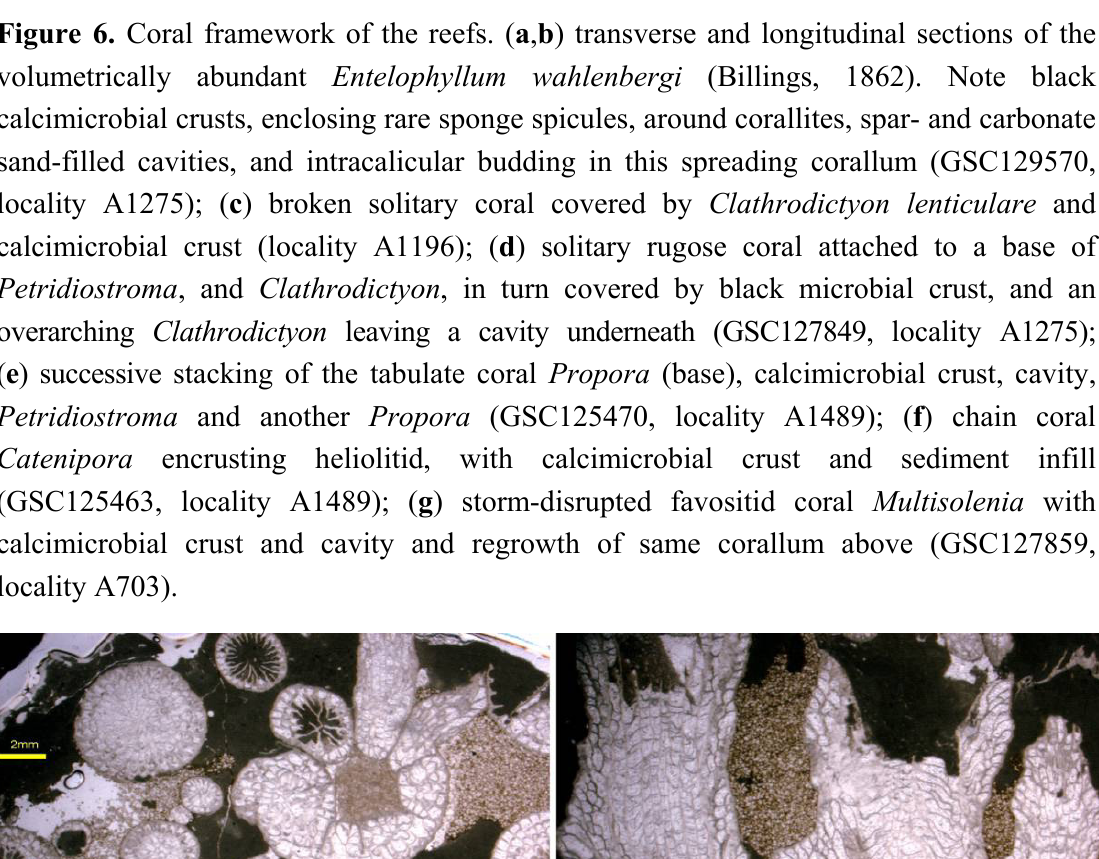
Figure 6. Coral framework of the reefs. ( a , b ) transverse and longitudinal sections of the volumetrically abundant Entelophyllum wahlenbergi (Billings, 1862). Note